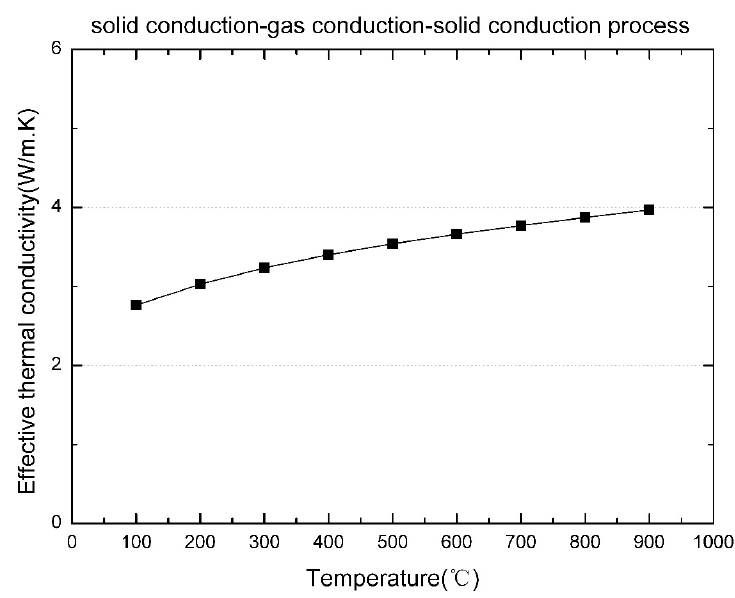
Figure 4. Effective thermal conductivity due to the solid conduction-gas conduction-solid conduction heat transfer process.